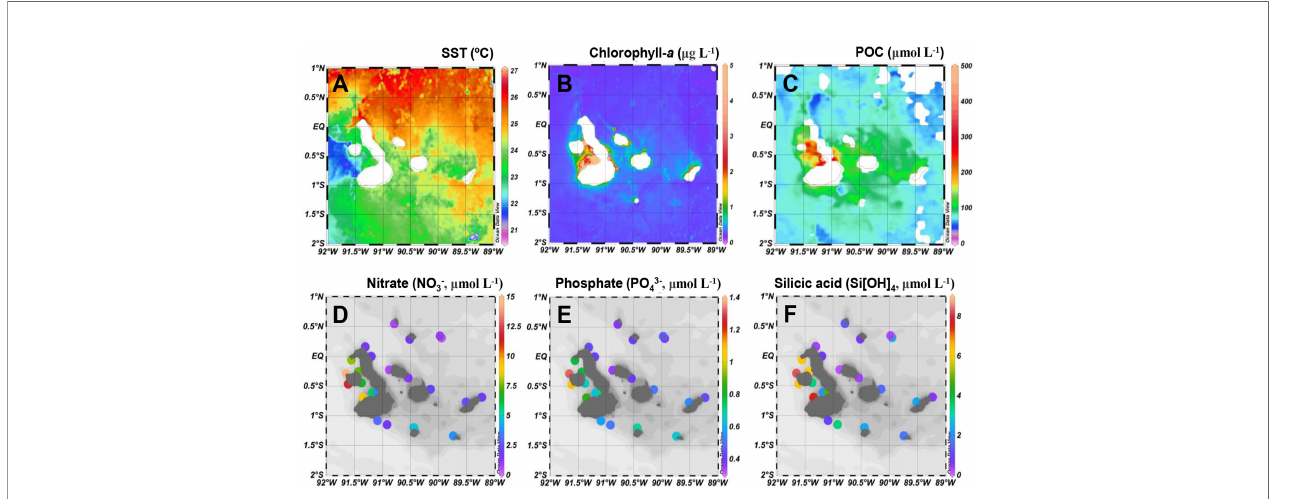
FIGURE 2 | Spatial distribution of (A) sea surface temperatures (SST, °C), (B) chlorophyll- a ( m g L -1 ), and (C) particulate organic carbon (POC, m mol L -1 ) concentrations derived from remote sensing during the survey period and dissolved nutrient concentrations ( m mol L -1 ) for (D) nitrate NO − 3 (E) phosphate PO 3 − 4 ,and (F) silicic acid (Si[OH] 4 ) measured in the mixed layer (50% incident irradiance